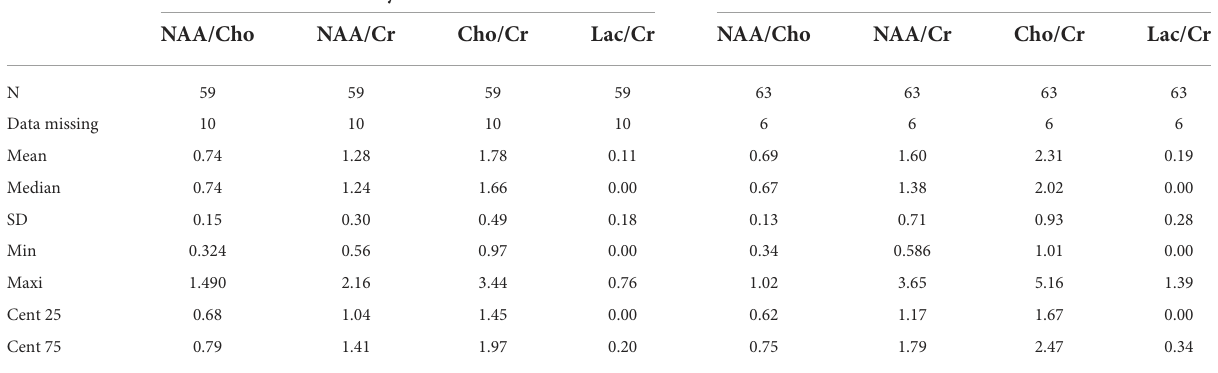
TABLE 4 Metabolite peak area ratios at term–equivalent age (TEA). Gray matter White matter NAA/Cho NAA/Cr Cho/Cr Lac/Cr NAA/Cho NAA/Cr Cho/Cr